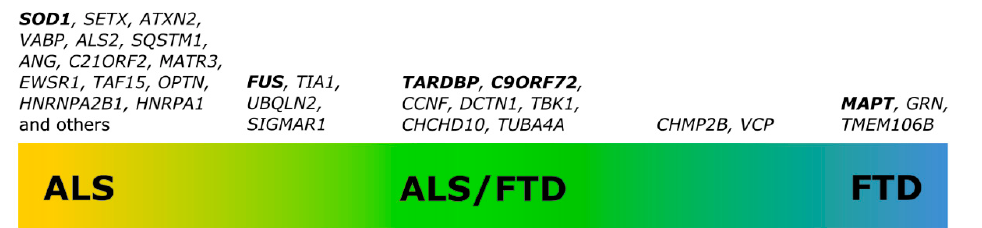
Figure 1. Genes involved in pathologies along the ALS-FTD spectrum. The most common genetic causes of the disease are highlighted in bold.